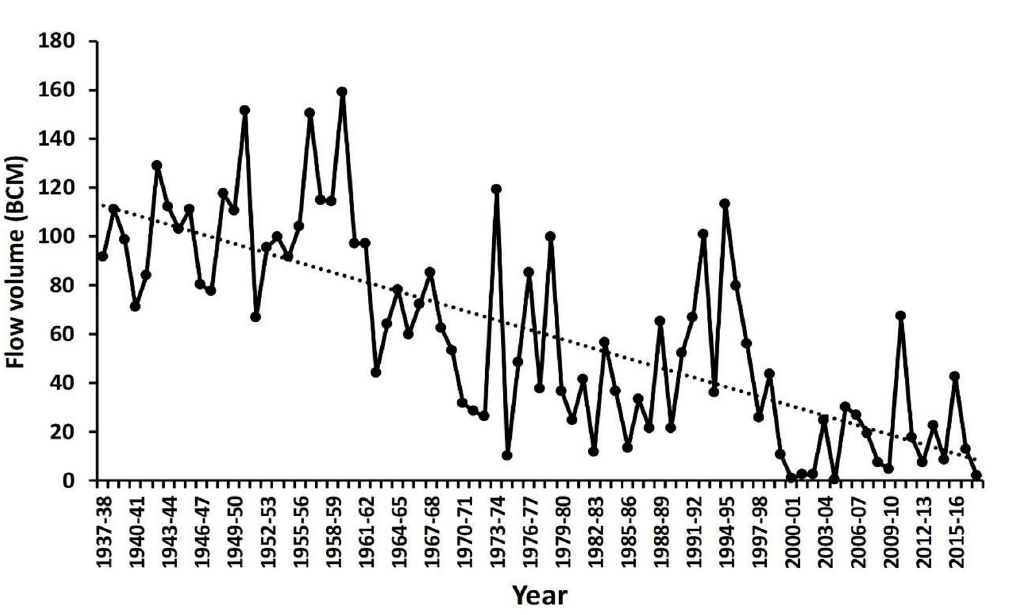
FIG. 7. THE DECREASE IN INDUS RIVER FLOW BELOW KOTRI BARRAGE WITH TIME